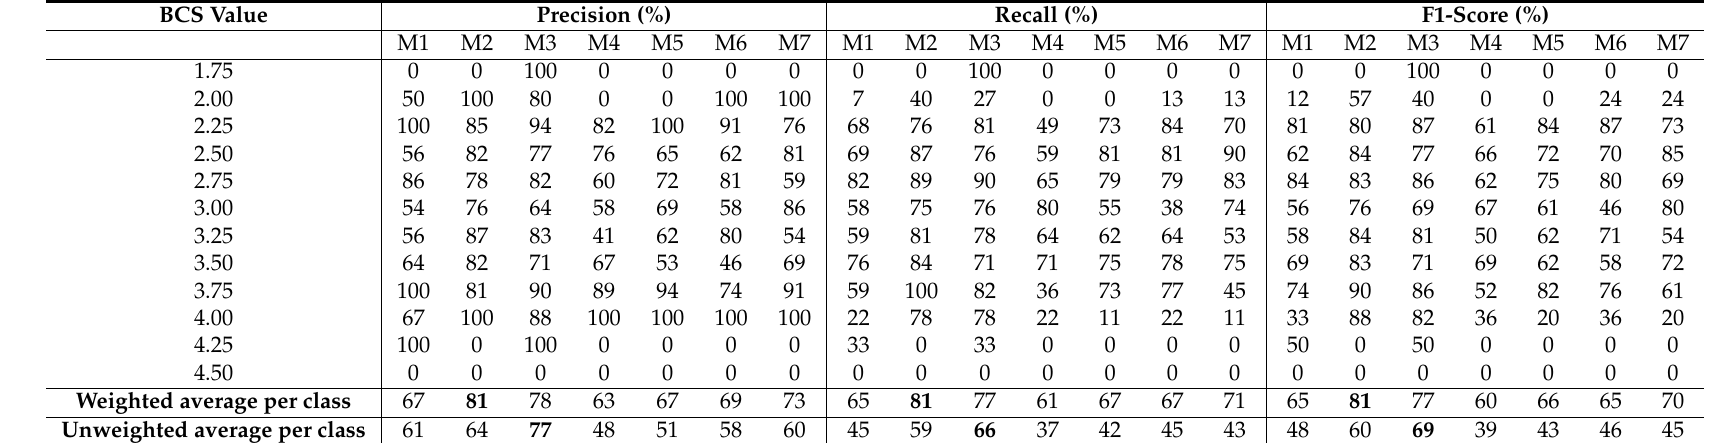
Table 4. Classification measures within 0.25 range error. Best results are in